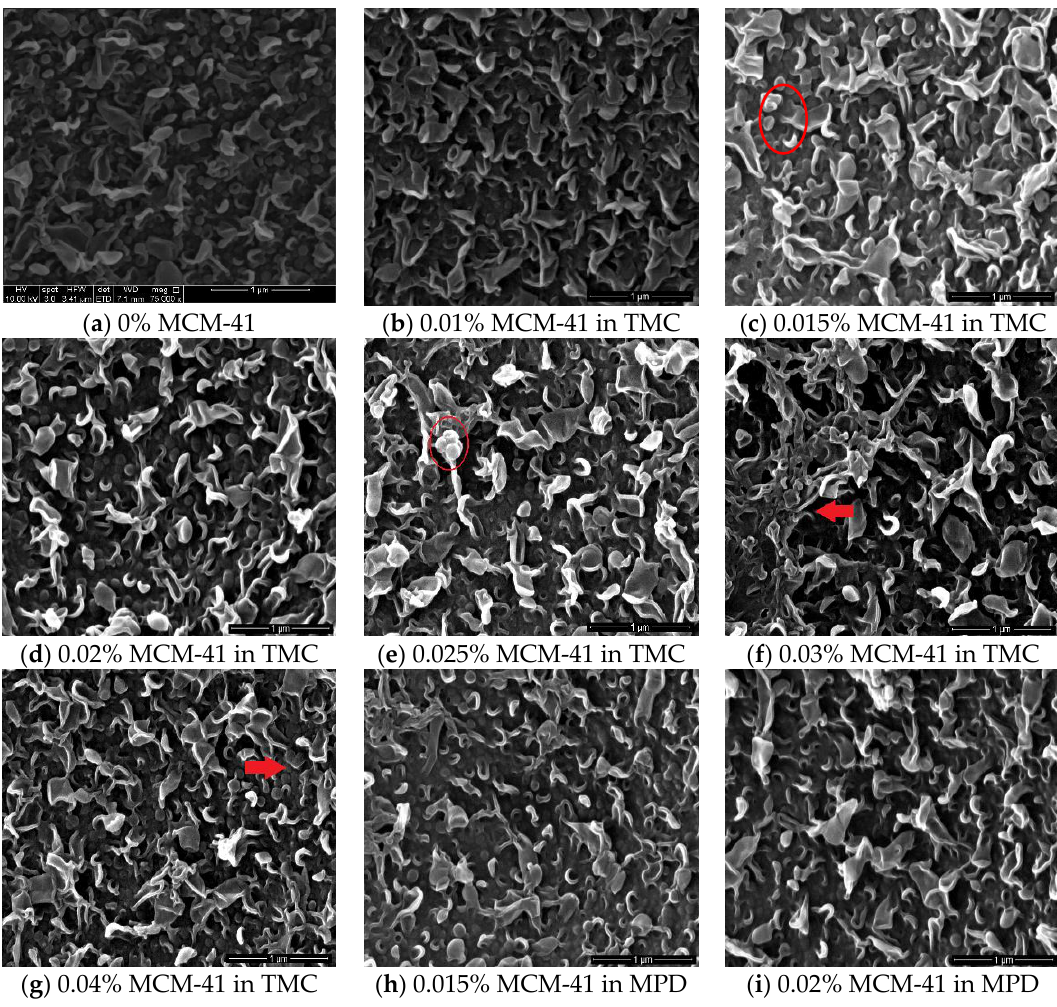
Figure 2. SEM images for membranes with differently loaded NPs: ( a ) TFC; ( b – g ) NPs in TMC sol and ( h – i ) NPs in MPD sol. ( h – i ) NPs in MPD